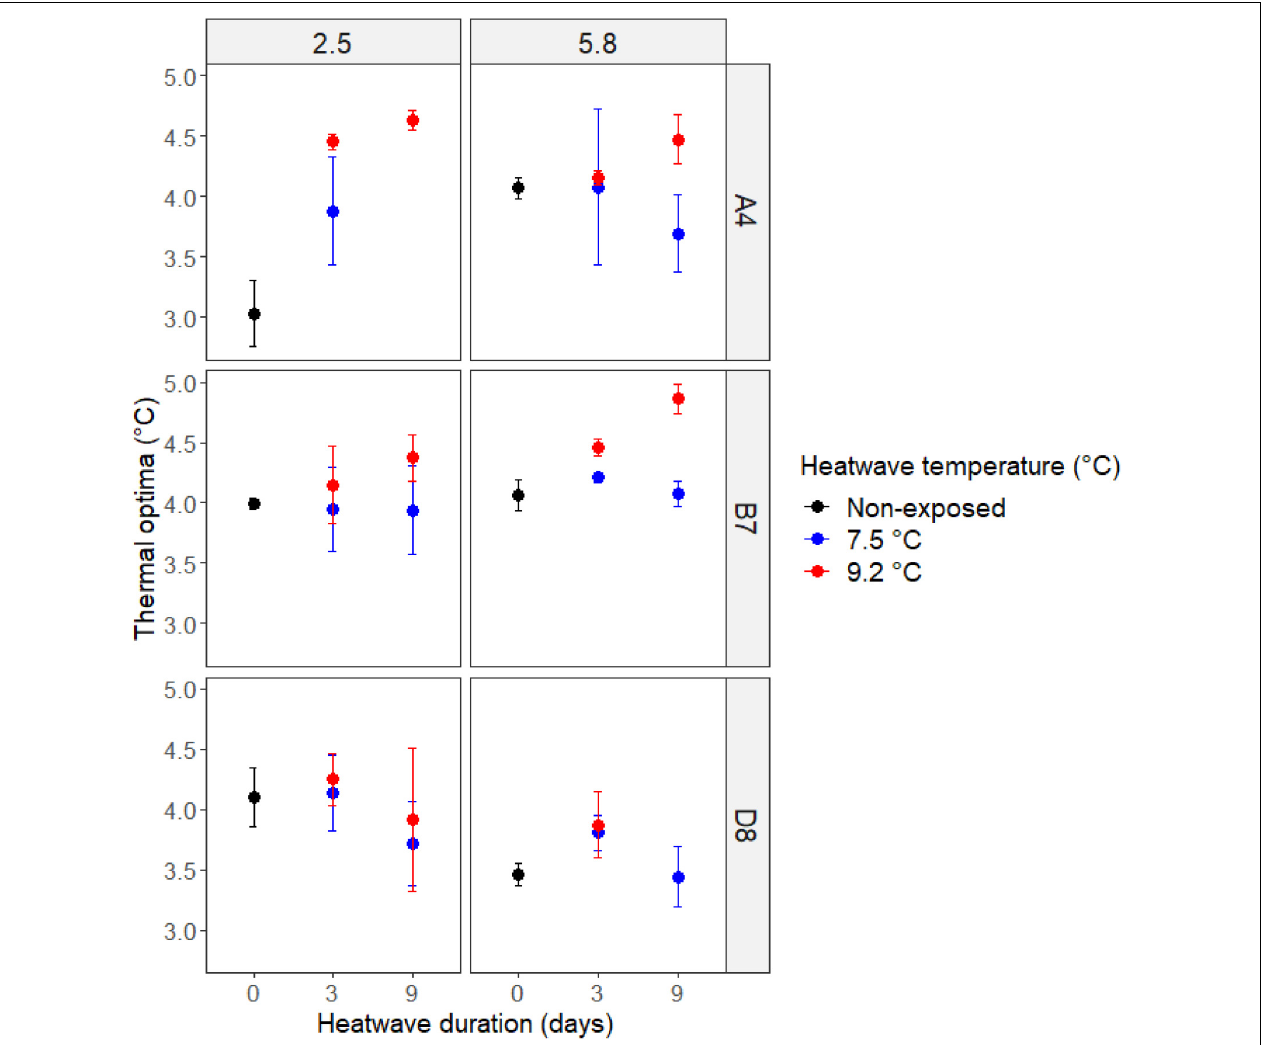
FIGURE 5 | Growth rate thermal optima ( ◦ C) of non-exposed (black) and heatwave exposed (red/blue) experimental populations. Thermal performance curves were produced for non-exposed populations (d0) and populations exposed to 3 and 9 days of heatwave exposure, for different acclimation temperatures (columns) and genotypes (rows). Error bars represent ± one standard deviation across three biological